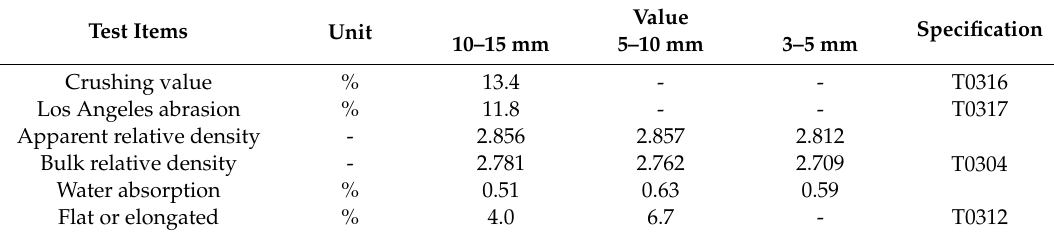
Table 2. Physical Properties of Coarse Aggregate.